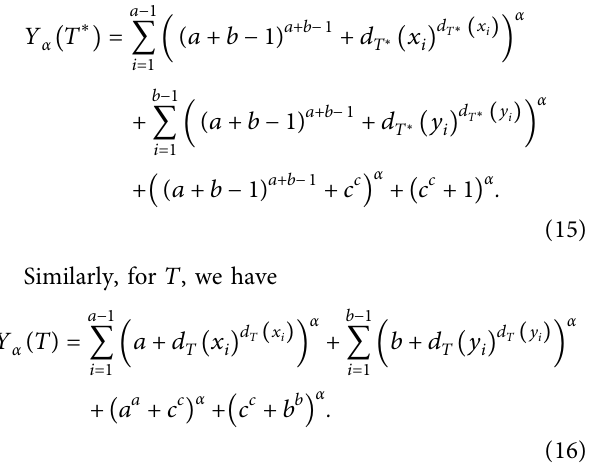
( P ) for various values of n n α